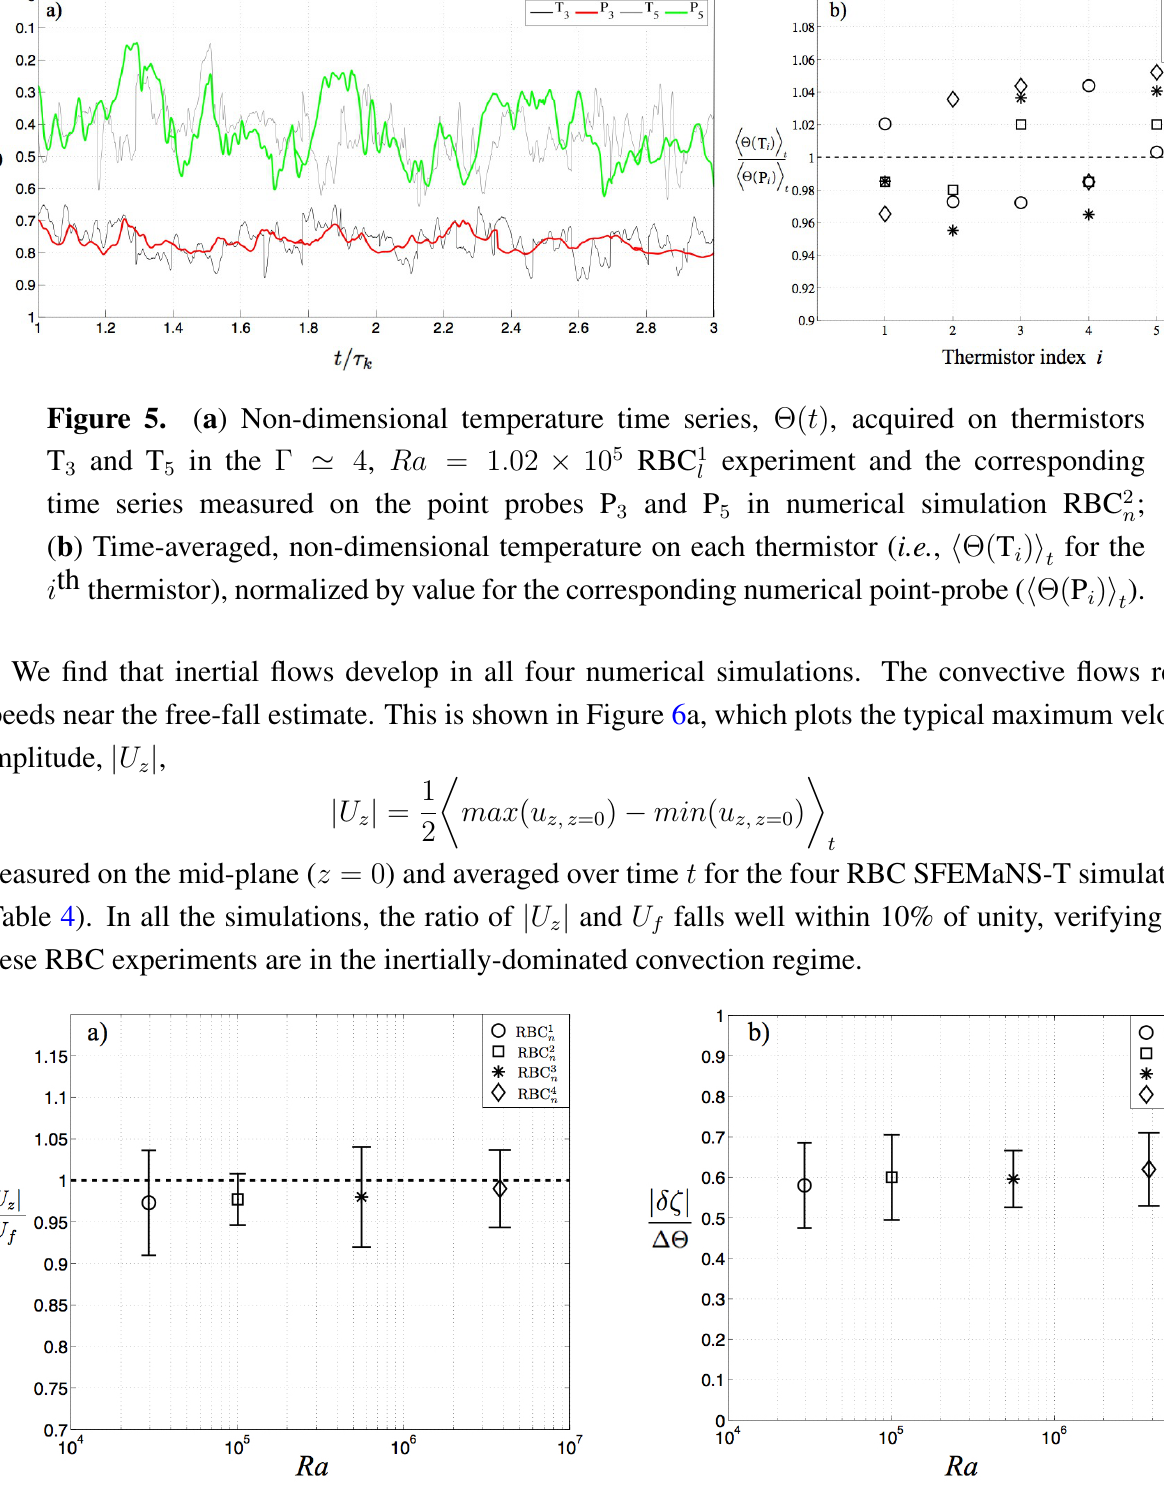
; ( b ) Maximum, time-averaged, f